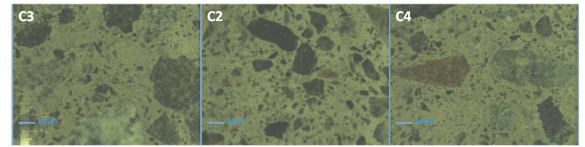
Fig. 7. Micrographs from C2, C3, and C4 concrete Table 7. Aggregate surface density ( Sv ) Technique